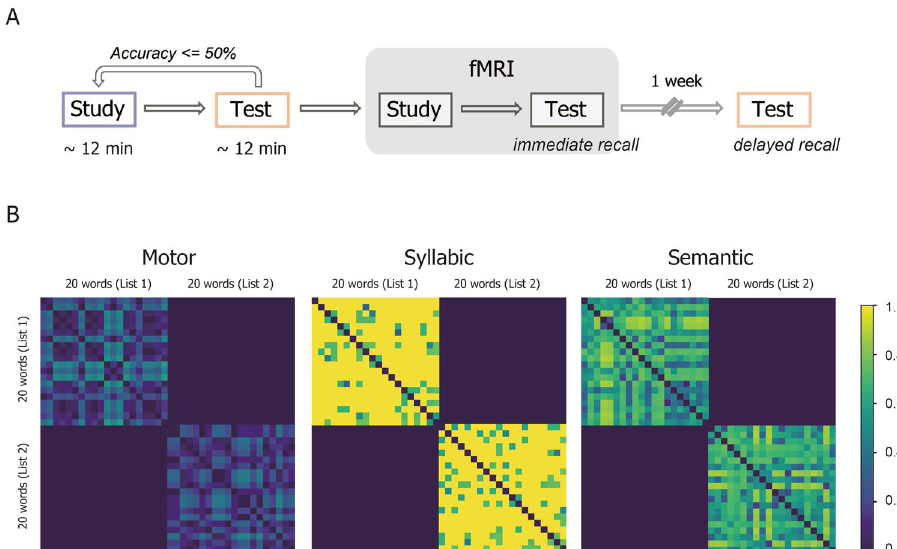
Fig. 1 Experimental paradigm. A The behavioral paradigm consisted of several study – test cycles for foreign language (FL) word learning. Participants fi rst heard and learned a list of 20 word pairs in a study period and then recalled the meanings of FL words in a test period. In the writing condition, participants studied each FL word while spelling it out with the right index fi nger, while in the no-writing condition, they studied the target word while keeping the right hand relaxed. The two conditions were performed in two separate sessions spaced at least 3 weeks from each other. During the test period immediately after the study period, participants were presented with FL words and asked to recall their meanings. This cycle of study and test was repeated outside the MRI scanner until participants achieved >50% accuracy in the test period. Participants then lay in the MRI scanner and received one additional cycle of study and test during fMRI scanning. Spoken responses were recorded and analyzed as “ immediate recall. ” One week after fMRI scanning, participants received the same recall test for each condition ( “ delayed recall ” ). B Three theoretical representational dissimilarity matrices (RDMs) used for multi-voxel pattern analysis. The motor RDM was created to characterize motor-level dissimilarity in writing movements between FL words. Pairwise comparisons of all possible word pairs yielded the motor RDM as a 40× 40 symmetrical matrix of which the off-diagonal values represent the dissimilarity for each pair of words at the